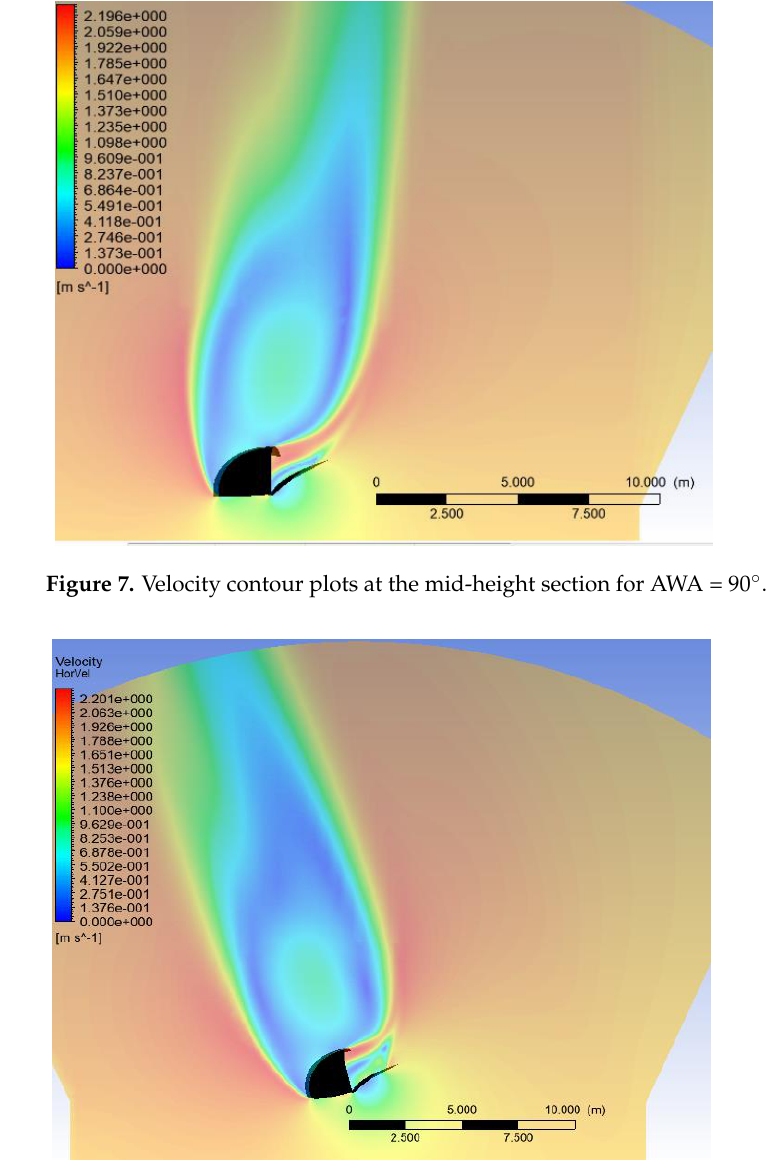
Figure 10. Iso-surfaces of Q-criterion for AWA = 115°. 2.2. FSI Analysis: Setup of FEM Environment As a result of the assumption of a rigid mainsail, FEM analysis was performed only on the downwind sail. The FEM model is parametric; the main parameters are the sail geometry, the Young’s modulus, the Poisson ratio , and the sail thickness. The geometry of the sail was automatically meshed using eight-node shell elements (Shell 281). This kind of shell element has six degrees of freedom at each node, and it is characterized by a math- ematical formulation suitable for simulating thin structures (like sails). Suitable mesh re- finements were applied on the head, the clew, and the tack. A convergence study was performed with five structural meshes, with the following average sizes for the shell elements: 200, 100, 5, 30, and 20 mm. The different analyzed meshes had about 1540, 5700, 9200, 12,870, and 18,574 elements, respectively. The result of the convergence study is shown in Figure 11, where the value of the maximum dis- placement is plotted as a function of the average element size.